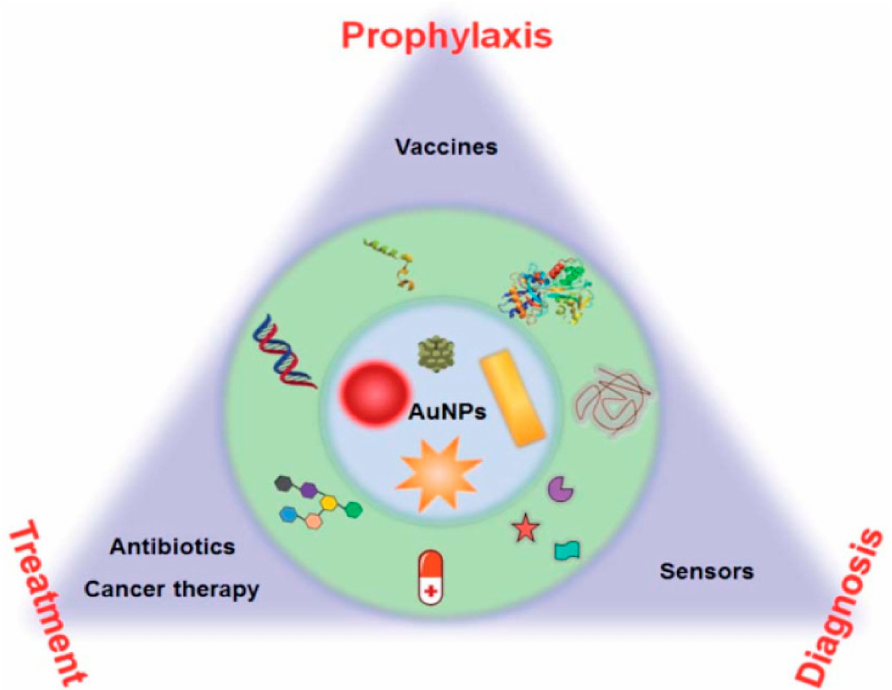
Figure 50. Schematic examples of implementations of prophylaxis-based health-related healthcare applications. Copyright 2016, Nat, reprinted with reference permission